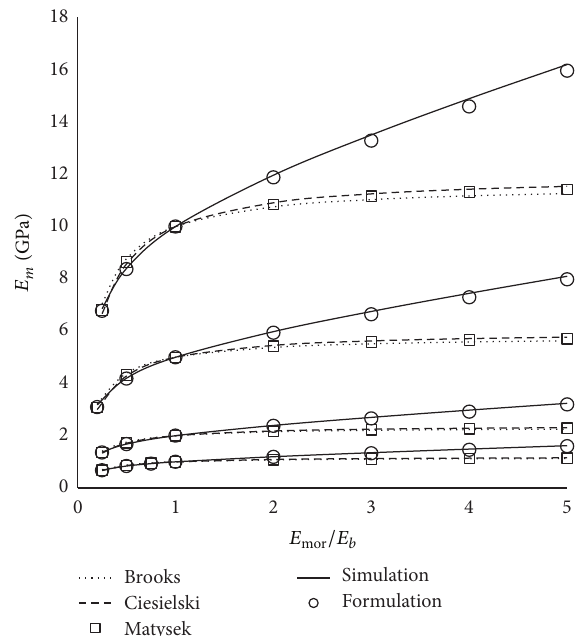
Figure 6: Equivalent elasticity of brick